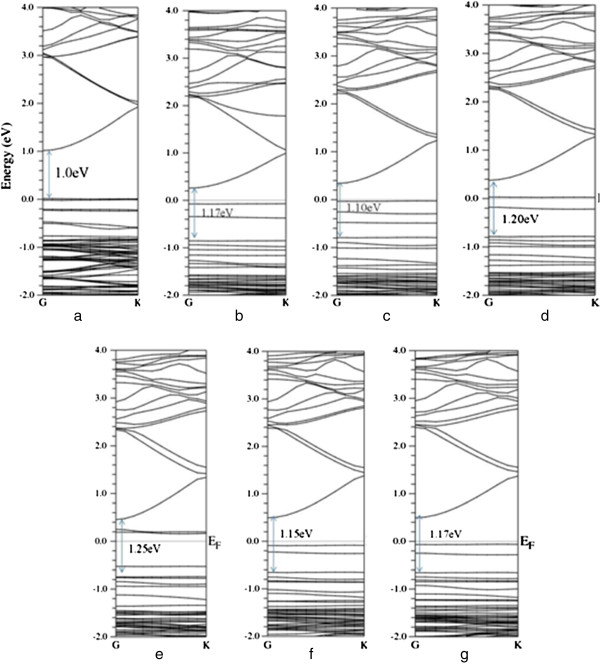
Band structures of pure and Ag-N-codoped (8,0) ZnO nanotubes. (a) Pure (8,0) ZnO nanotube, (b) Ag1 configuration, (c) Ag1N2 configuration, (d) Ag1N3,4 configuration, (e) Ag1N2,3,4 configuration, (f) Ag1N5 configuration, and (g) Ag1N6 configuration.